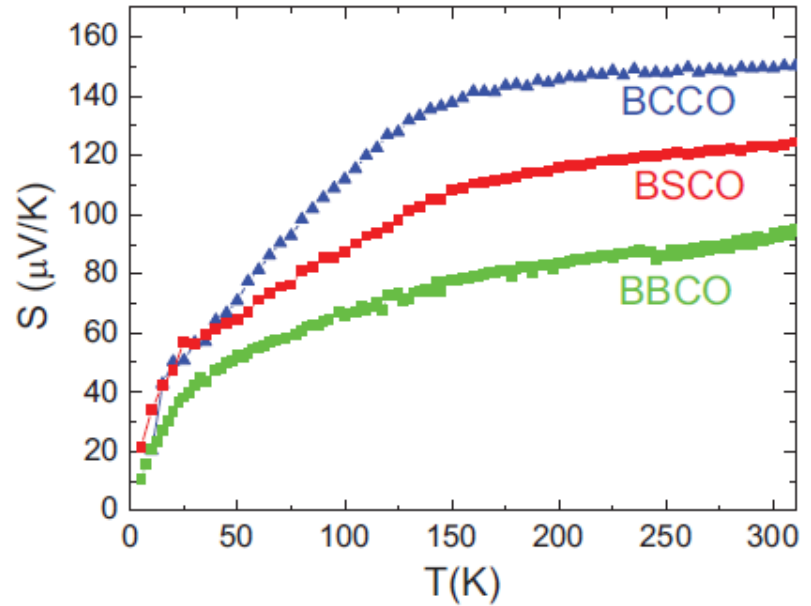
Figure 10. In-plane thermopower S for BBCO, BSCO, and BCCO single crystals (adopted with permission from Wiley−VCH from Reference [53] ).